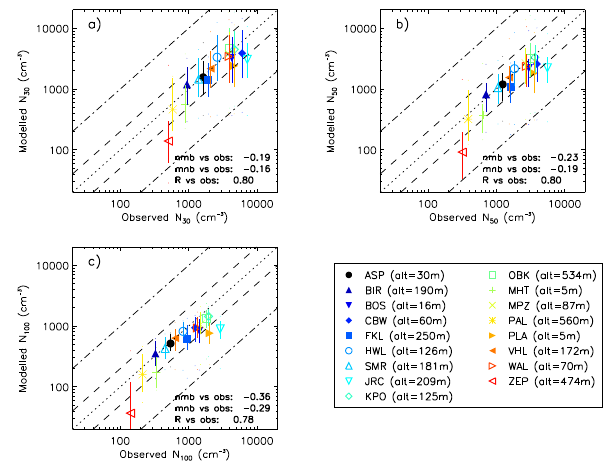
Figure 10. Simulated annual mean surface N(D p > 30nm (a) , > 50nm (b) and > 100nm (c) , against those measured by SMPS/DMPS instruments at 17 of the EUSAAR/GUAN sites (ex- cludes those at high altitude, taken as above 900m altitude). Model values are the geometric mean of the central two-thirds model annual-means, with the vertical whiskers indicating the minimum and maximum values over those central 8. Observed values are arithmetic means over the hourly measurement data (A. Asmi, per- sonal communication,